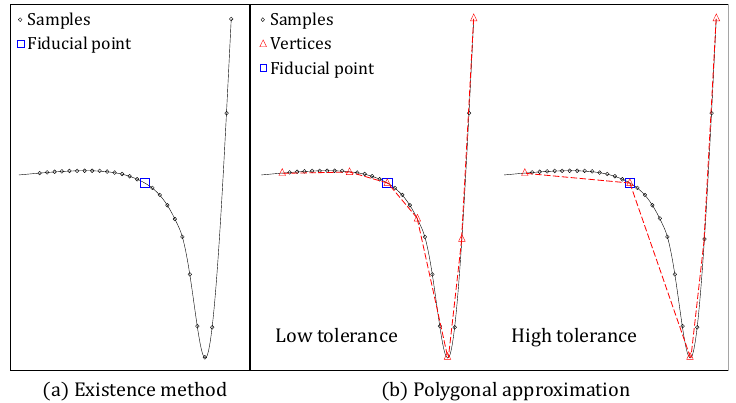
Figure 1. Motivation of the proposed